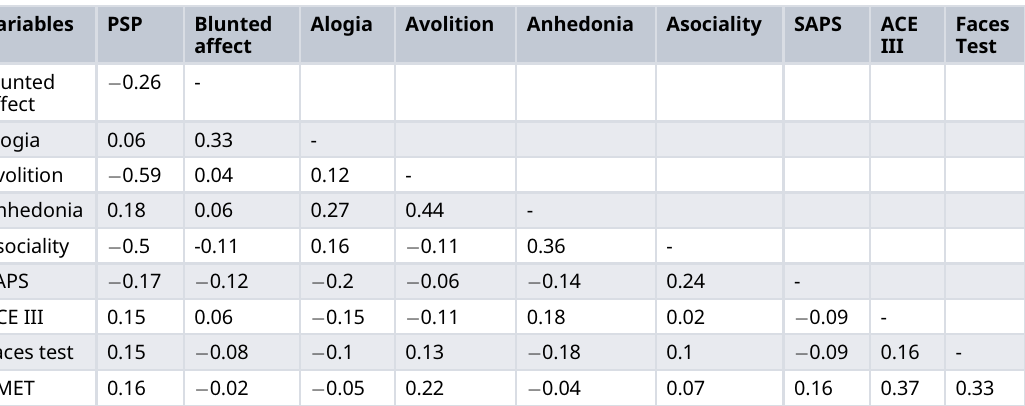
Table 2. Partial correlation matrix between 10 network analysis variables.